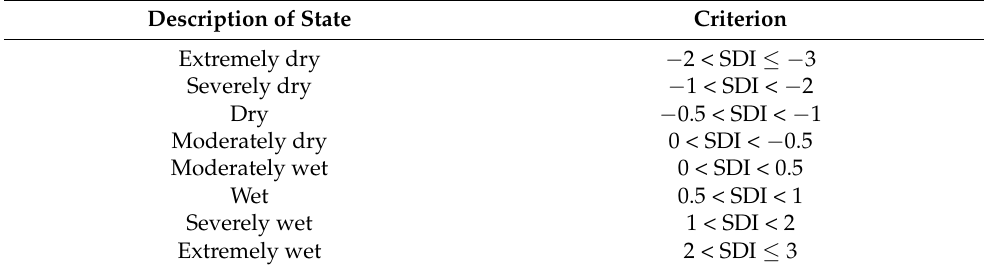
Table 1. Description of hydrologic stated based on a modified streamflow drought index (SDI) criterion by Garza-D í az and Sandoval-Solis